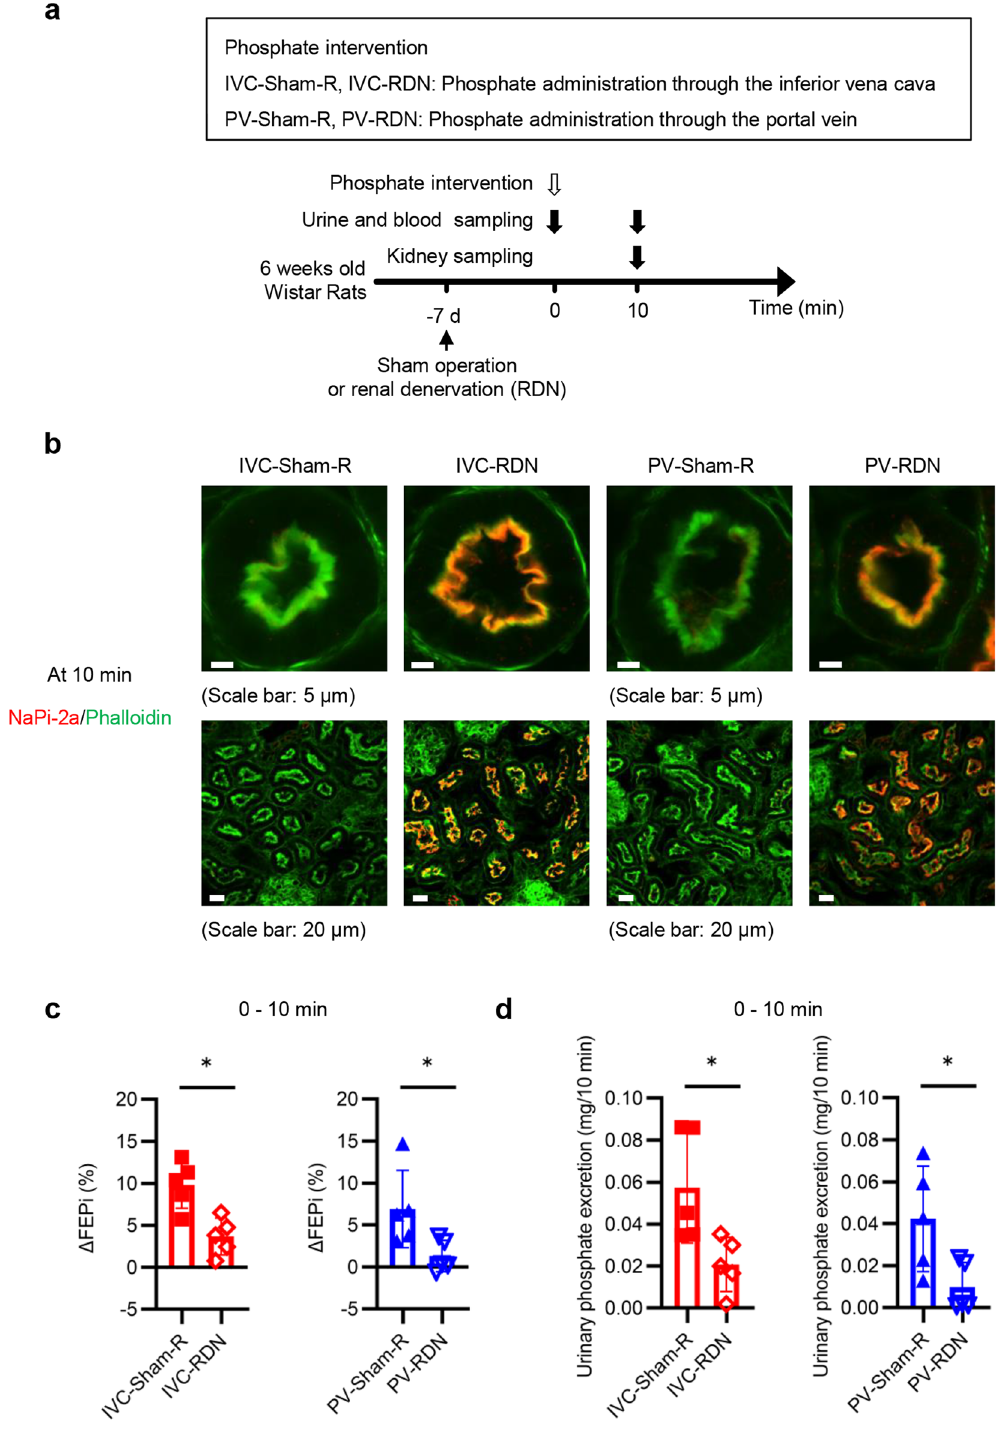
Figure 7. The renal sympathetic nerves played critical roles in the elevation of FEPi between 0 and 10 min and urinary phosphate excretion during the 10-min period. ( a ) Experimental design of ( b ) to ( d ). Sham-operated rats and renal- denervated (RDN) rats were randomly divided into four groups, IVC-Sham-R, PV-Sham-R, IVC-RDN, and PV-RDN. Seven days after the operation, rats in the IVC-sham-R and IVC-RDN groups and in the PV-Sham-R and PV-RDN groups received phosphate interventions similar to those in the IVC and PV groups, respectively. ( b ) Representative immunofluorescence images of renal PTECs stained with phalloidin (green) and NaPi-2a (red) at 10 min. The upper and the lower images in each group are the immunofluorescence images with higher and lower magnification, respectively (scale bars: 5 µm or 20 µm). (c) ΔFEPi between 0 and 10 min (n = 5 rats per group). ( d ) Urinary phosphate excretion during the 10-min period (n = 5 rats per group). All results are presented as the means ± SDs, n.s.: not significant. * P < 0.05 based on the two-tailed Student’s t- test in ( c ) and ( d